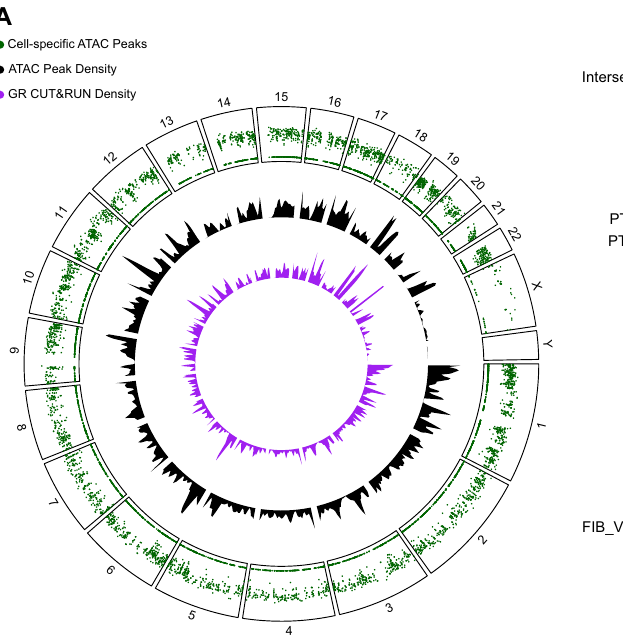
intersect with bulk kidney GR CUT&RUN sites. The solid black circles in each col- umn indicate which cell types are present within the intersection at the top of the plot. For example, the fi rst column is a group of 14 ATAC peaks shared between PCT, ENDO, B-cells, and T-cells that each contain a GR CUT&RUN site that is not seeninothercelltypes.OnlyintersectionswithtenormoreGRCUT&RUNsitesare included in the plot. GR CUT&RUN sites that do not intersect a cell-speci fi c ATAC peakaredisplayedastheblackbartothefarright( N =1296).Thehorizontalbarson therightoftheUpsetplotrepresentthetotalnumberofpeakswithineachcelltype or GR CUT&RUN group (Source data is provided in Supplementary Dataset 2 and